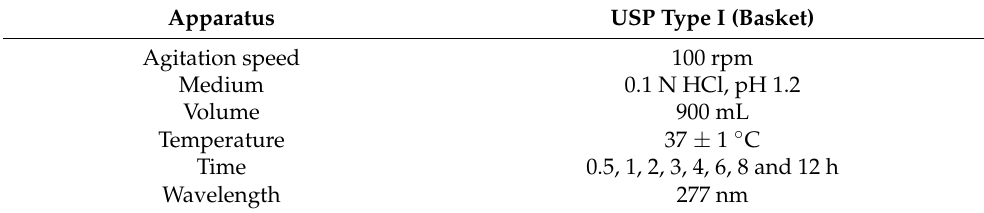
Table 7. Experimental pre-set conditions of dissolution apparatus.